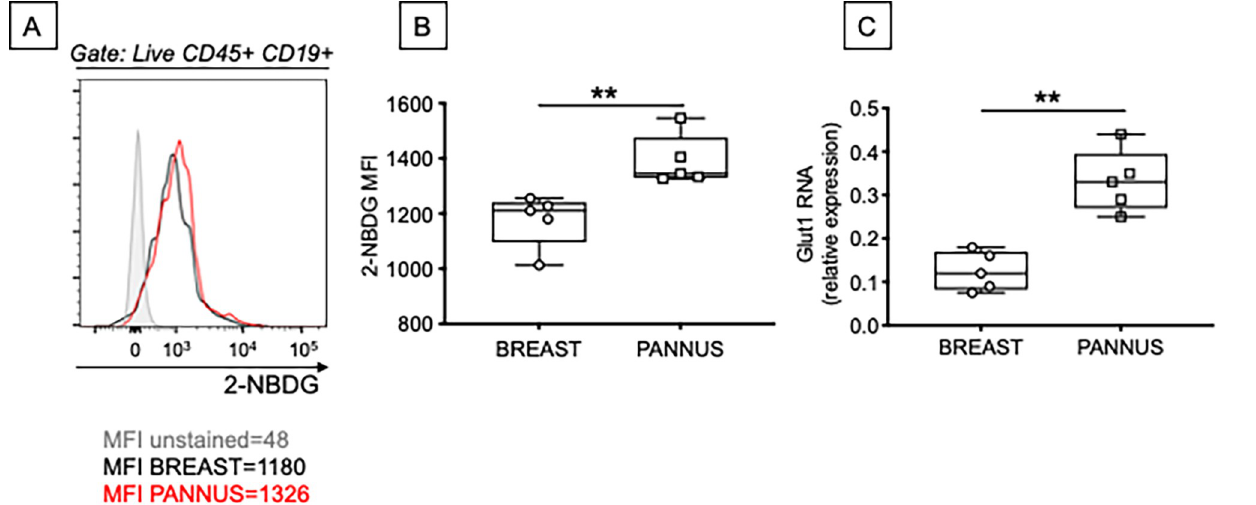
Fig 6. B cells sorted from the pannus, as compared to those sorted from the breast, express higher levels of 2-NBDG and of the RNA for Glut1. B cells were isolated from pannus and breast SVFs using flow cytometry and cell sorting. After sorting, B cells were left unstimulated and divided in two aliquots, one evaluated by flow cytometry for 2-NBDG expression, and another resuspended in TRIzol for RNA expression of Glut1. A. Results show MFI of 2-NBDG staining in B cells sorted from pannus and breast SVFs from one representative experiment, as compared to the unstained control. B. MFI ± SE of 2-NBDG staining from all samples. C. Results show qPCR values of RNA expression of Glut1, relative to GAPDH, calculated as 2 - Δ Cts in the same B cells in A. Mean comparisons between groups were performed by Student’s t test (two-tailed). ** p < 0.01. Each symbol represents an individual, n = 5 breast donors and n = 5 pannus donors.